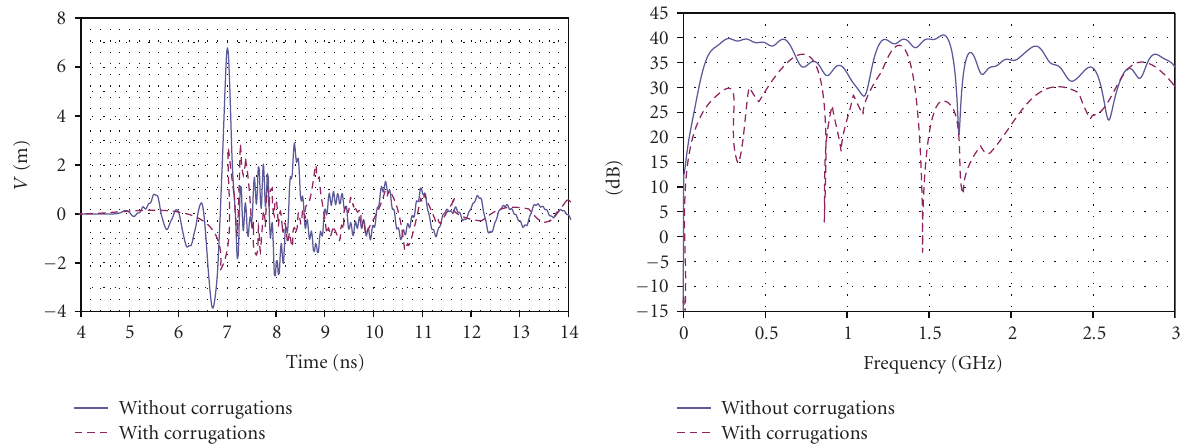
Figure 15: Back signal ( Ez ) with and without corrugations.